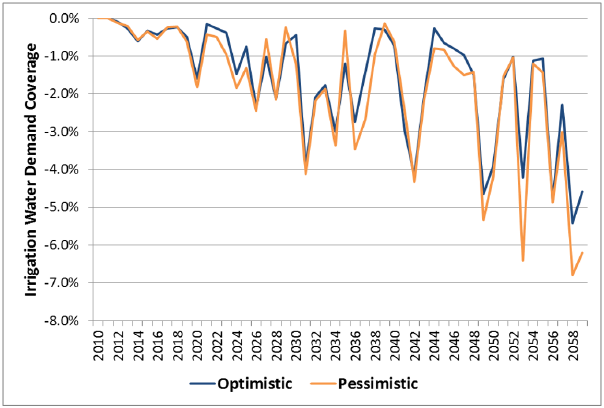
Figure 6. Quiroz-Chipillico watershed model’s change in water demand coverage for irrigation units supplied by the San Lorenzo reservoir.